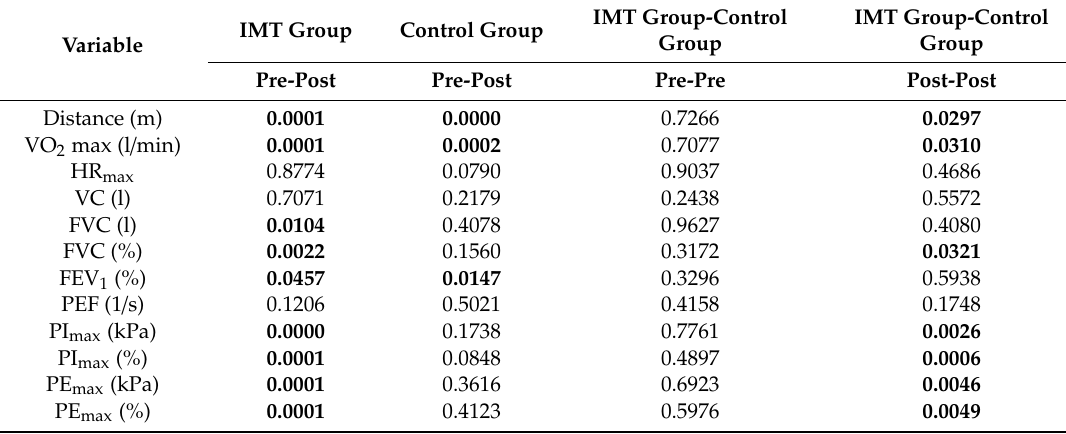
Table 5. The results of analysis of variance of the parameters and subsequent Duncan’s post hoc test (statistically significant di ff erences are marked in